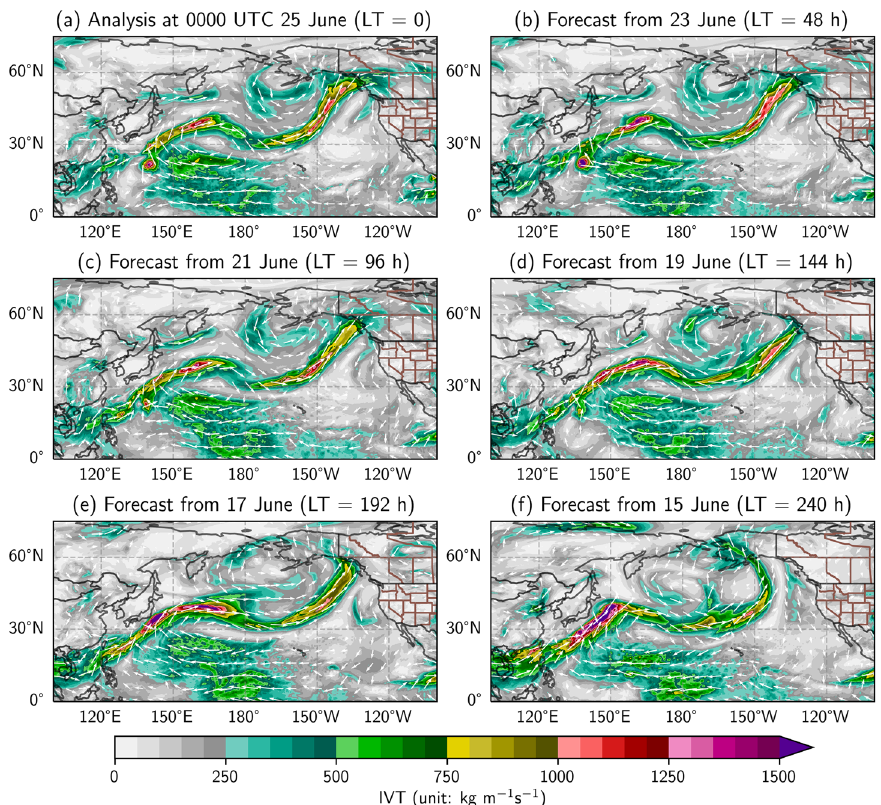
Fig. 8 Distributions of the IVT valid at 0000 UTC 25 June 2021 based on the Canadian GDPS operational outputs. a The GDPS analysis. b – f The GDPS predictions with different lead times (LT).